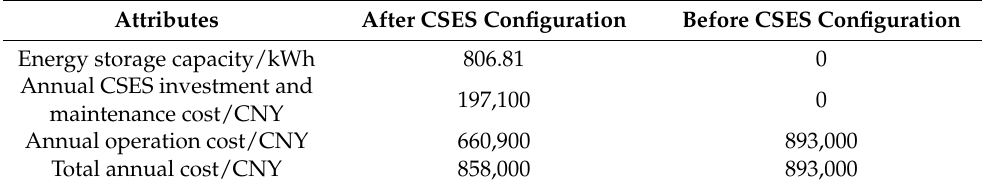
Table 3. Simulation results before and after CSES